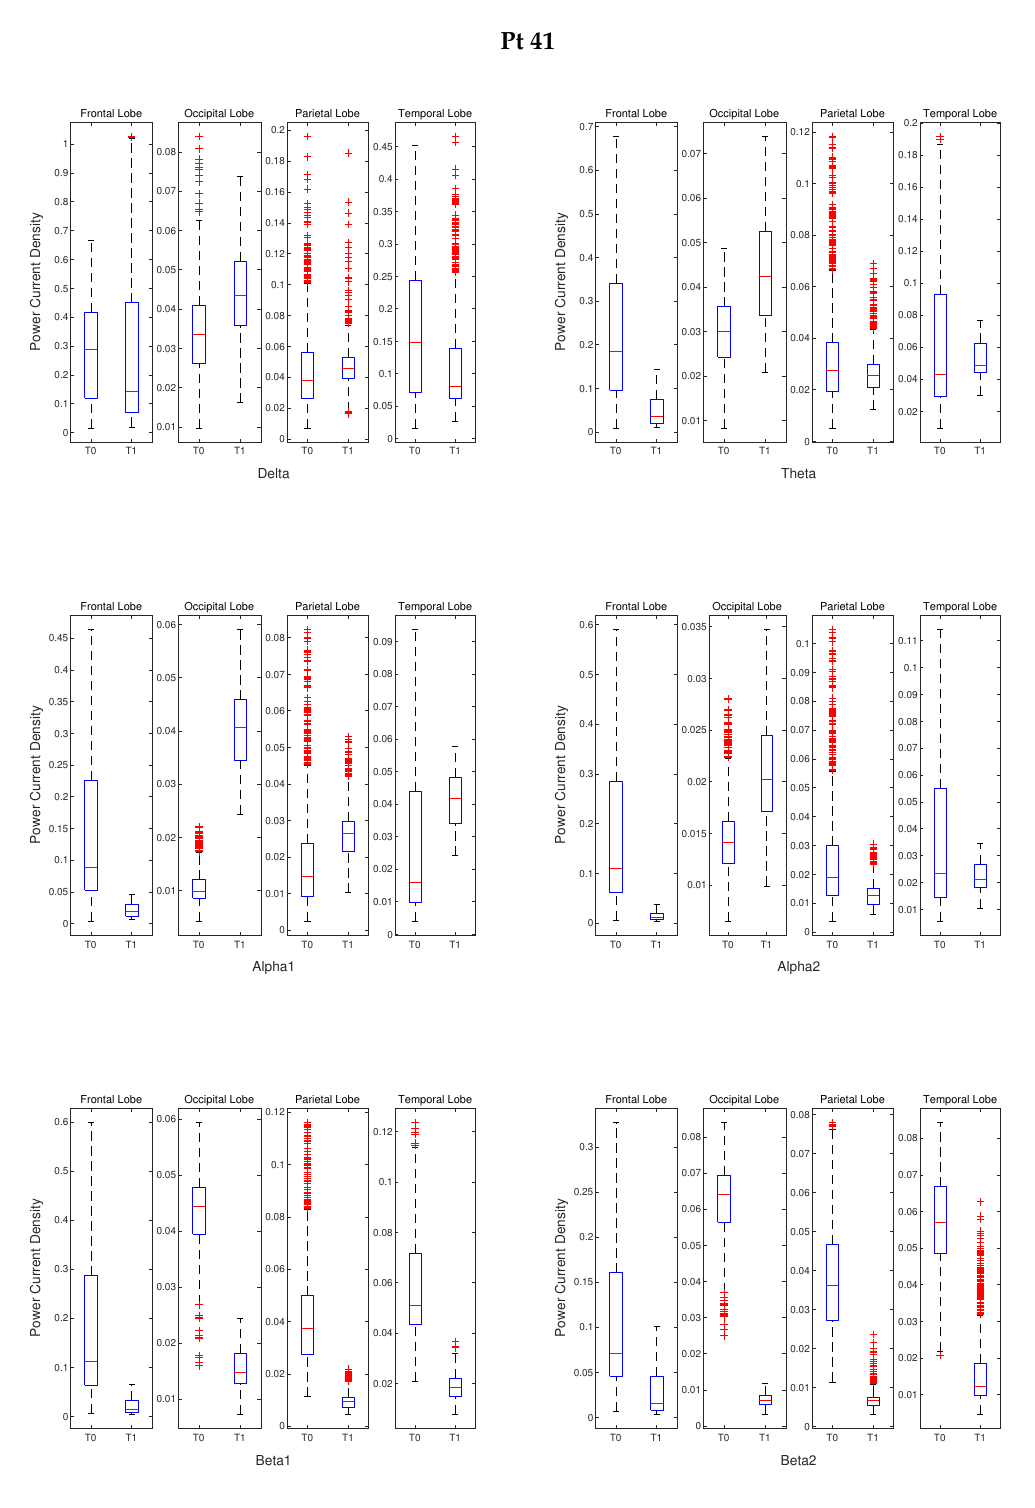
Figure 4. Boxplot of the power current density of patient 41 at time T0 and T1 for each frequency sub-band and each region of interest (frontal, occipital, parietal, and